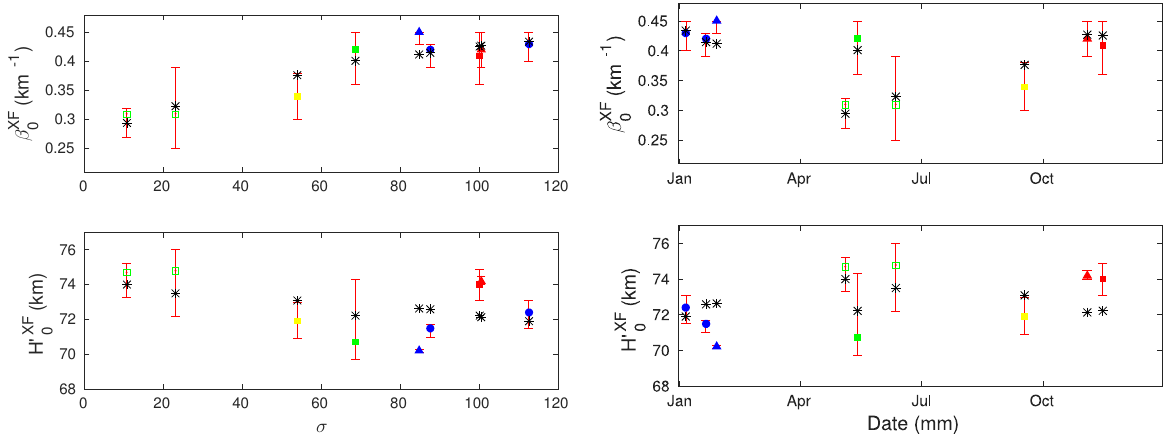
Figure 8. Dependencies of the “sharpness” β ( upper panels ) and signal reflection height H (cid:48) on the smoothed daily sunspot number σ ( left panels ) and season ( right panel ). The modeled values β XFmidday periods near the solar cycle maximum) and open (for periods near the solar cycle minimum) scatters. Different seasons are described by blue (winter), green (spring), yellow (summer), and red (autumn) scatters. Scatters marked by "*" indicate values obtained from Equations (16) and